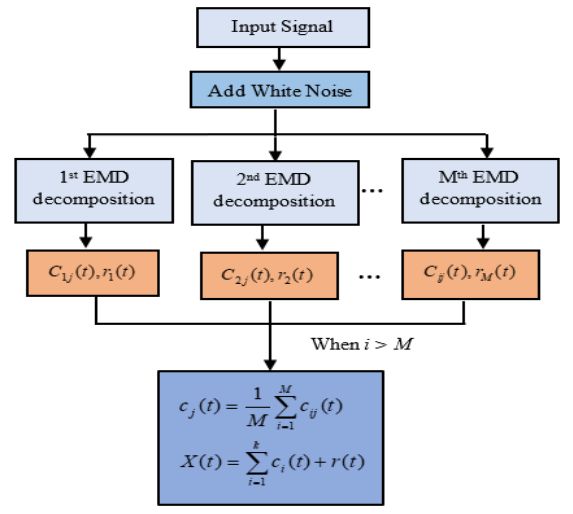
Figure 3. Steps of the EEMD method.